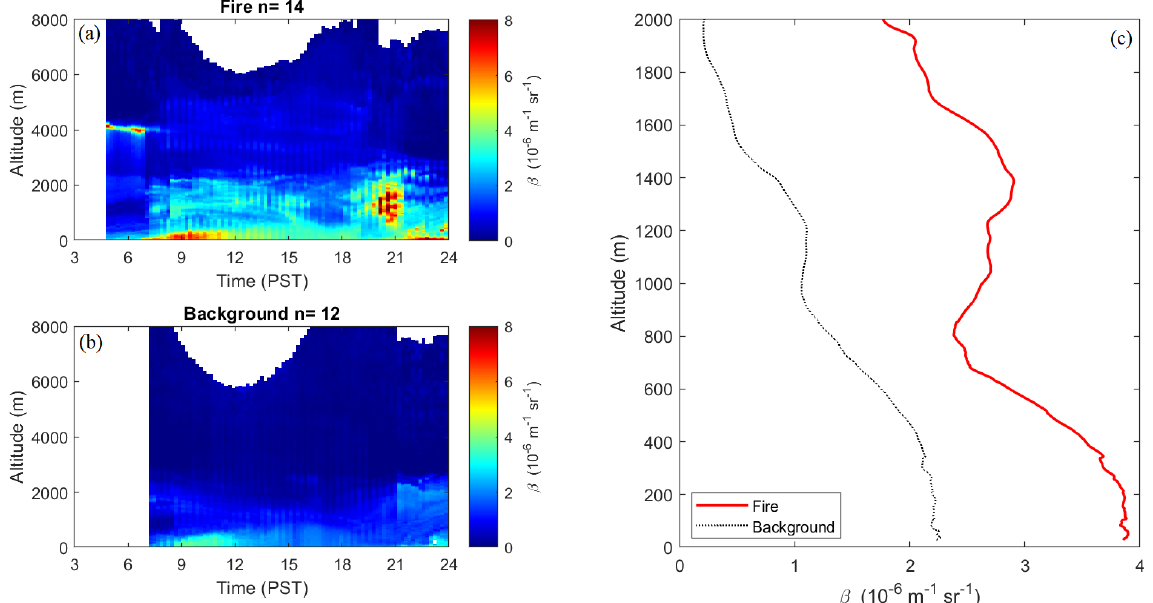
Figure 8. Aerosol backscatter profile for TOPAZ during CABOTS 2016. The plots are the averaged diurnal profile for wildfire days (a) and background days (b) during 18 July to 7 August 2016. Averaged vertical backscatter profiles for wildfire days (red) and background days (black) between 13:00 and 15:00PST are in (c) . The n is the number of days in each plot. The TOPAZ produces a vertical profile for every 12min with a resolution of